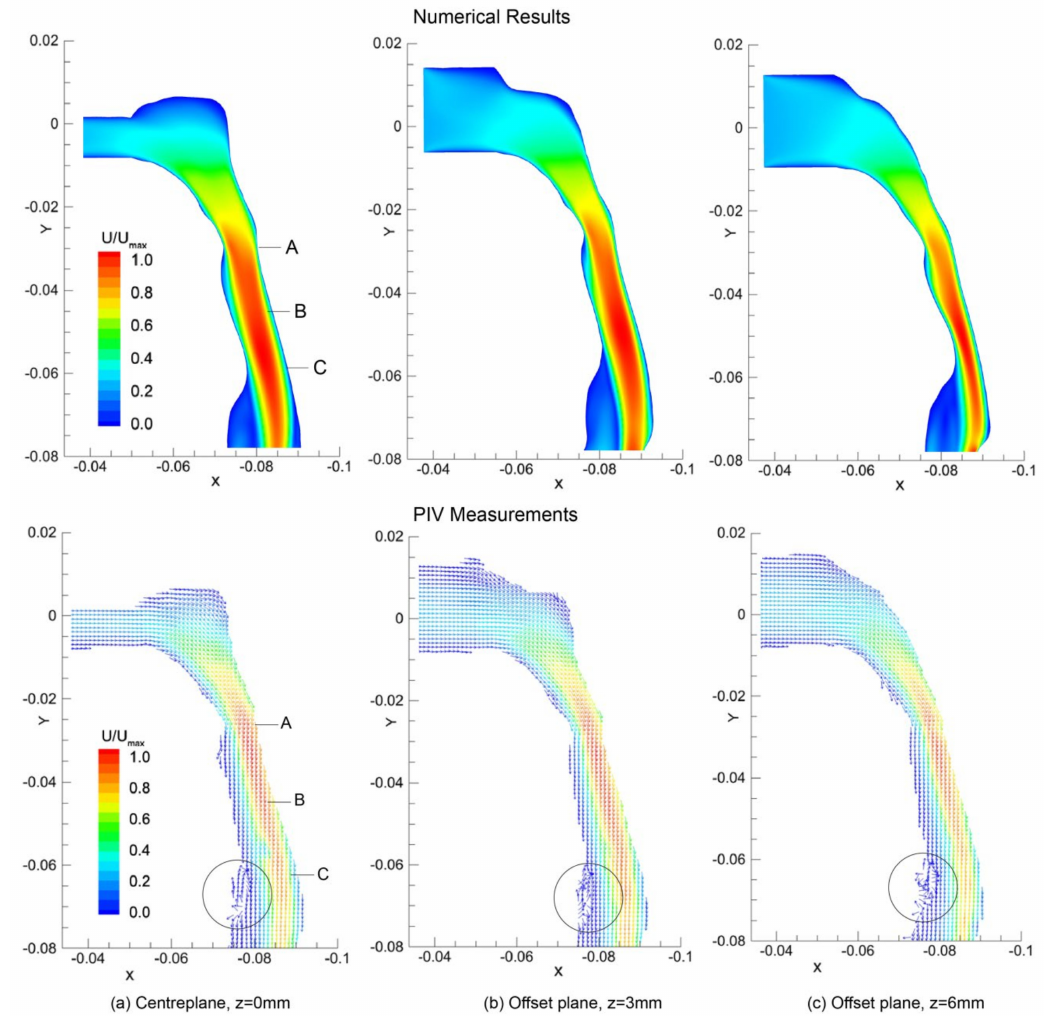
Figure 5. Velocity contours (CFD) and Velocity vectors (PIV) plot in the sagittal planes at ( a ) z = 0 mm ( b ) o ff set z = 3 mm plane, and ( c ) o ff set z = 6 mm plane, and normalised by the global maximum velocity. The plot axis units are in metres. Vectors are uniform in length to emphasis regions of recirculation, highlighted with circles. Landmark locations include: (A)-minimum cross-sectional area in the velopharynx; (B)-oral pharyngeal junction; and (C)-epiglottis